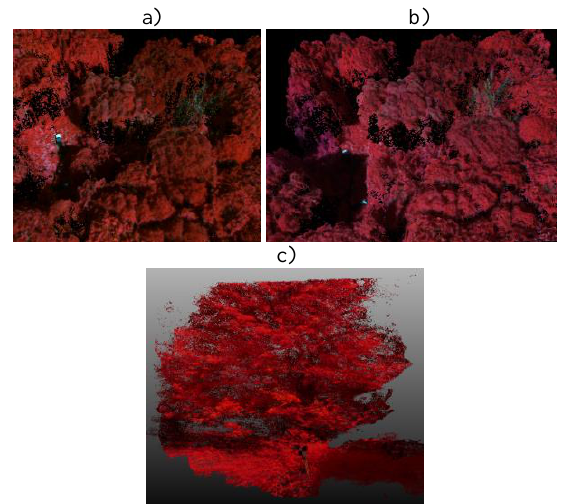
Figure 12. Hyperspectral point clouds from a) morning and b) afternoon UAV flights and c) terrestrial